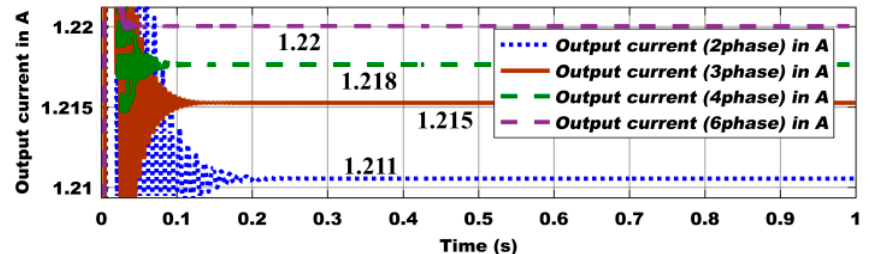
Figure 3. Output current comparison of MPIBC at duty cycle of 50%.